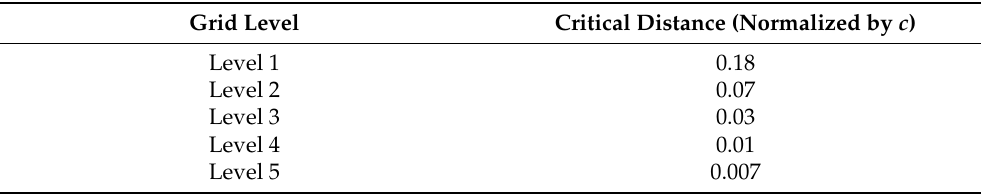
Table 1. Critical distances for different grid levels.